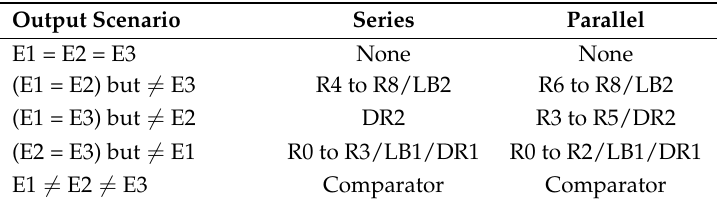
Table 1. Possible Damaged Part of the